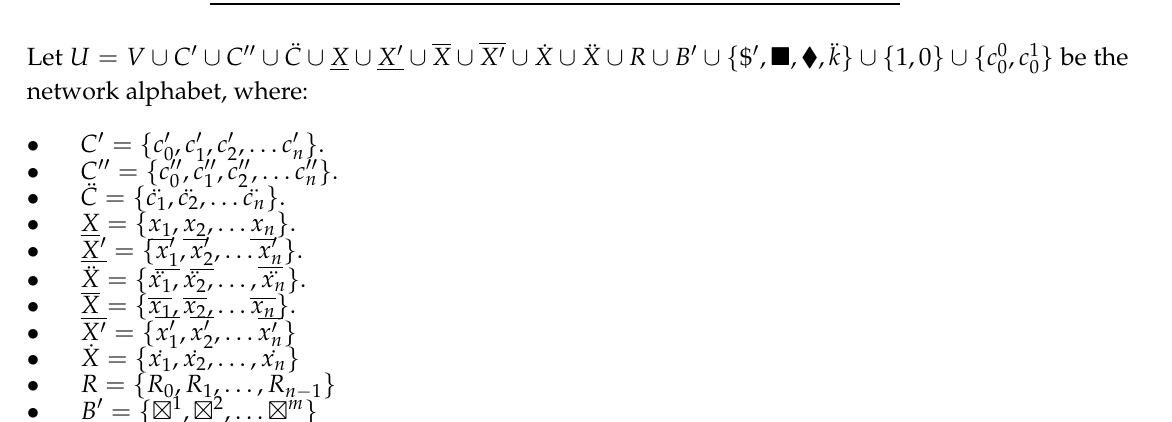
( k ) ∑ 3 p x i x j + ∑ 3 i = 1 j = i i , j